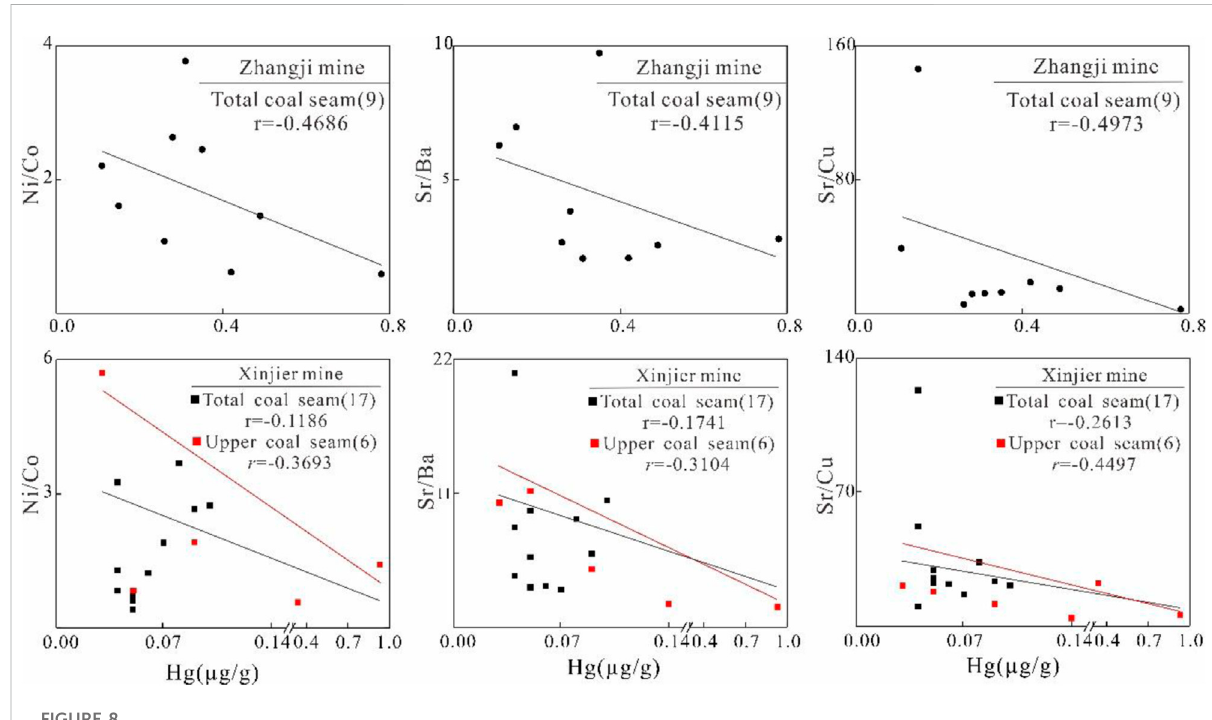
FIGURE 8 Correlation analysis of mercury and depositional environment in